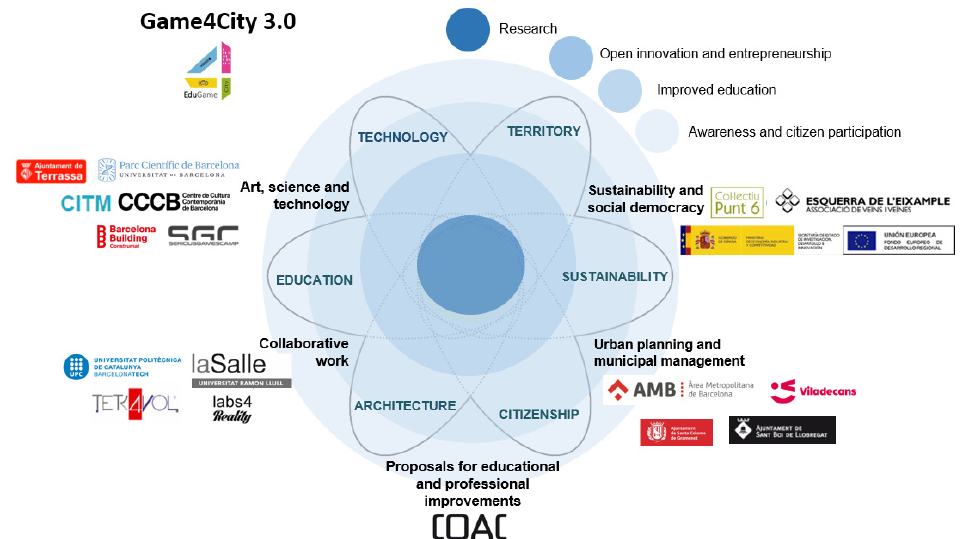
Figure 1. Global Game4City project scopes, lines of action and agents. The project has two sub-projects: ArchGame4City developed by UPC, and EduGame4City developed by URL.